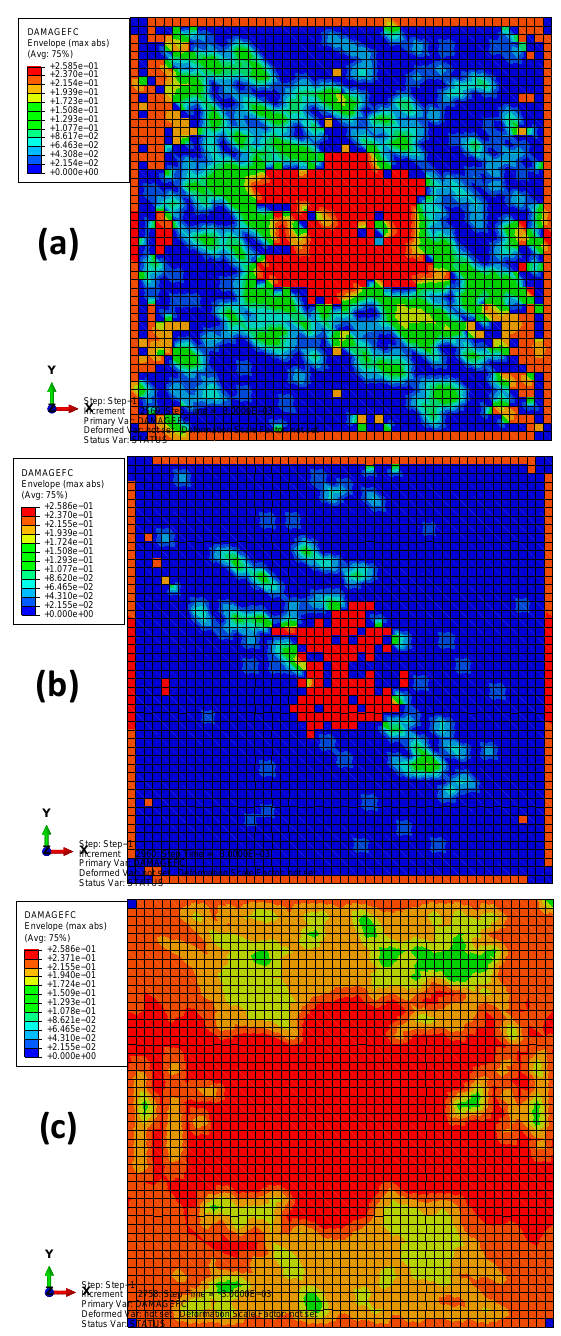
Figure 11. The fiber compression damages of the three models after bird impact: ( a ) material 1; ( b ) material 2; ( c ) material 3.